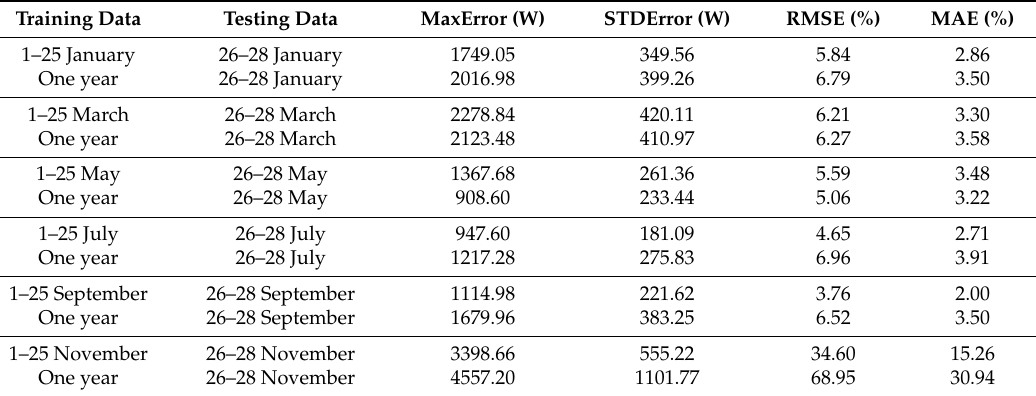
Table 4. Error analysis. MaxError: maximum error; STD: standard deviation; RMSE: root-mean-square error; MAE: mean absolute